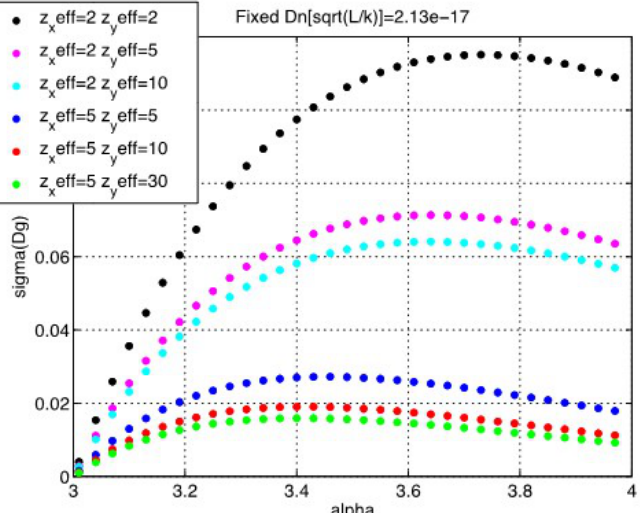
Figure 17. Scintillation flux with fixed structure function at the Fresnel distance for six pairs of anisotropic factors along the x and y axes (shown as z x eff and z y eff in the legend). Reprinted with permission from Reference